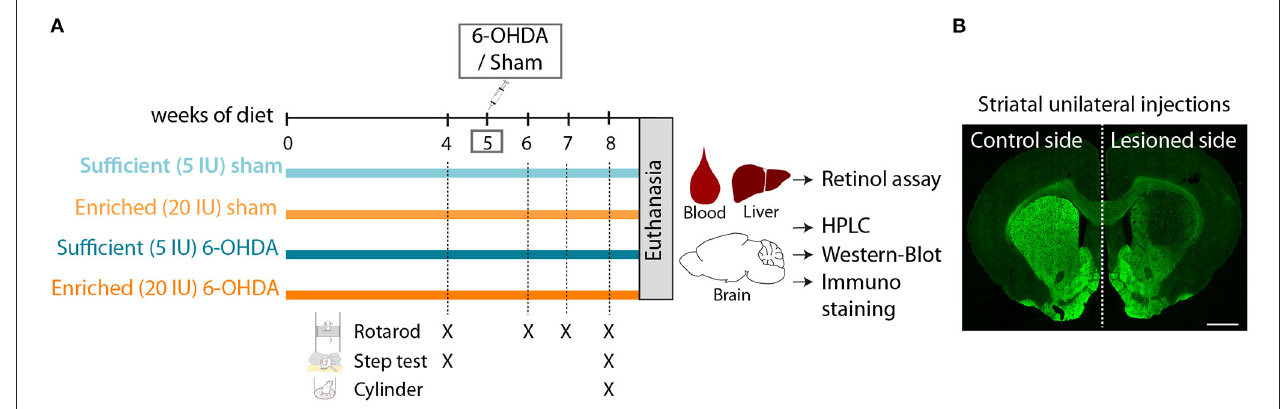
FIGURE 1 | Experimental design. (A) Schematic overview of experimental design. 5 IU and 20 IU stand for 5 IU/g of diet and 20 IU /g of diet, respectively. (B) Representative image of rat striatum (bregma + 1.6) injected with 6-OHDA (lesioned side), labeled with TH immunofluorescence (green). Scale bar: 1000 µ m.